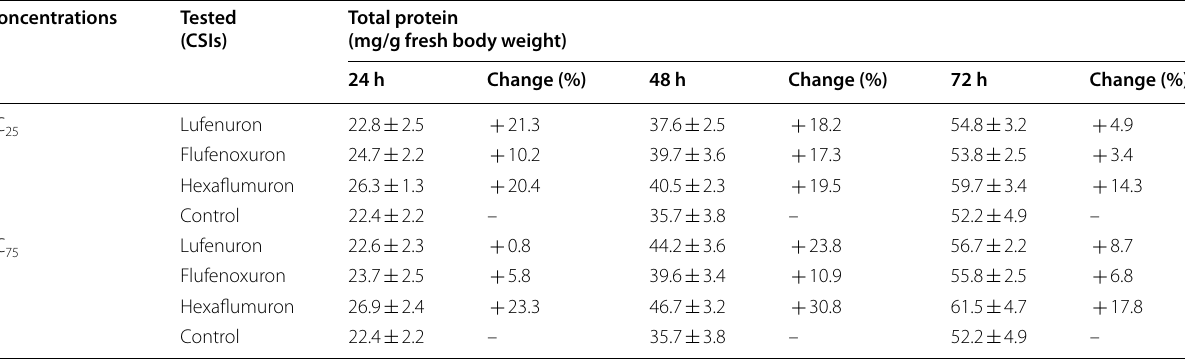
Table 3 Effect of lufenuron, flufenoxuron and hexaflumuron on the total protein content of the house fly M. domestica penultimate larval instar treated with the LC and LC concentrations at different time intervals 25 75 Concentrations